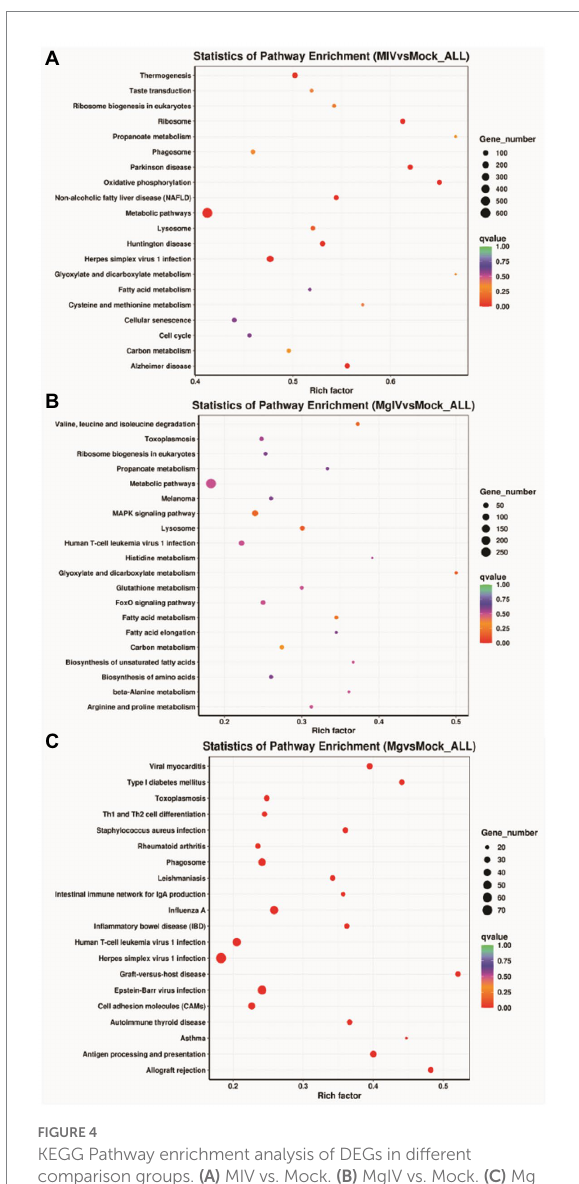
FIGURE 4 KEGG Pathway enrichment analysis of DEGs in different comparison groups. (A) MIV vs. Mock. (B) MgIV vs. Mock. (C) Mg vs. Mock. The name of KEGG pathways are on the y-axis. q-value (range 0–1) is the p -value that was corrected by multiple hypothesis tests. The closer the q-value is to zero, the more significant the enrichment of the KEGG